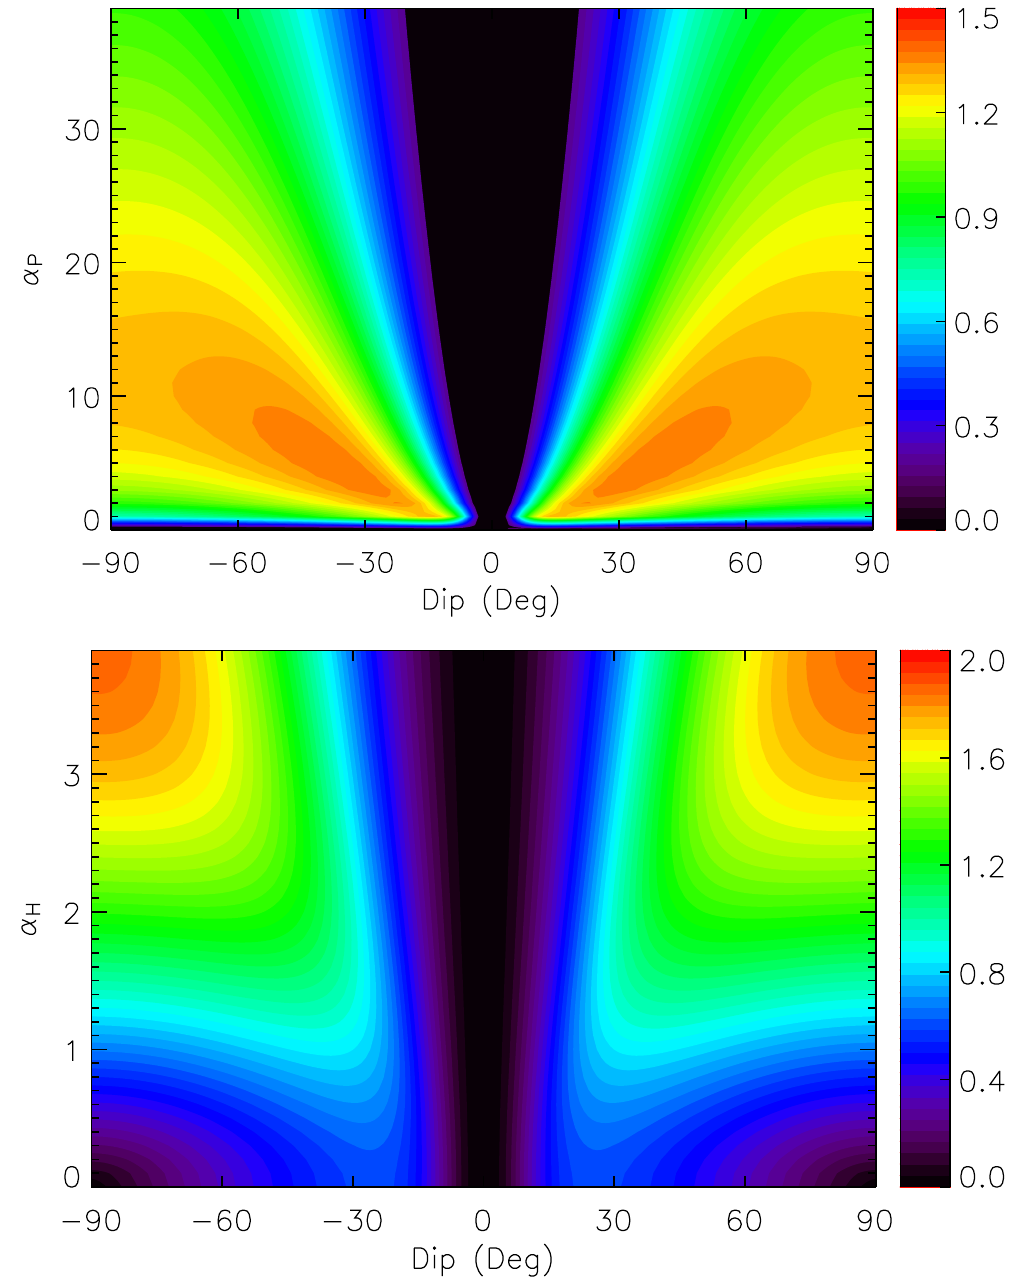
Fig. 5. The normalised, orizontal ULF magnetic field at the ground as a function of dip angle for f=20mHz, V a = 1 × 10 6 ms − 1 , k x =0, k y =1/d and d=100km. (a) Variation with α P for α H = 2. (b) Variation with α H for 6 P =